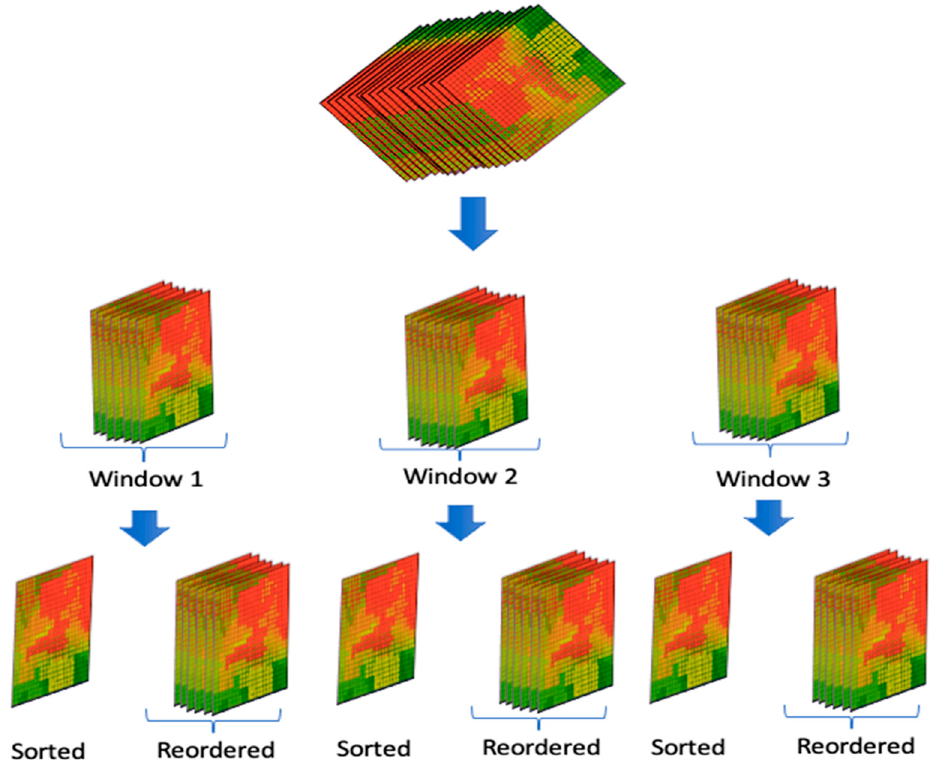
Figure 5. Strategy to avoid sorting all the